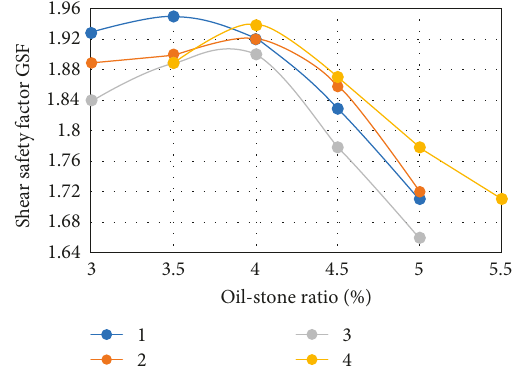
Figure 2: Relation between AC-16 porosity and oil-stone ratio.